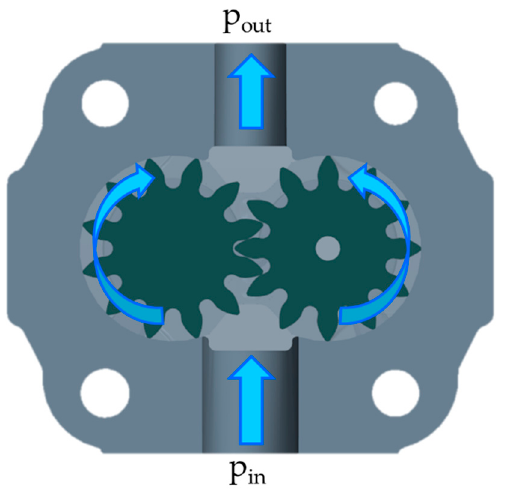
Figure 1. Fluid transfer direction within an external gear pump (EGP).